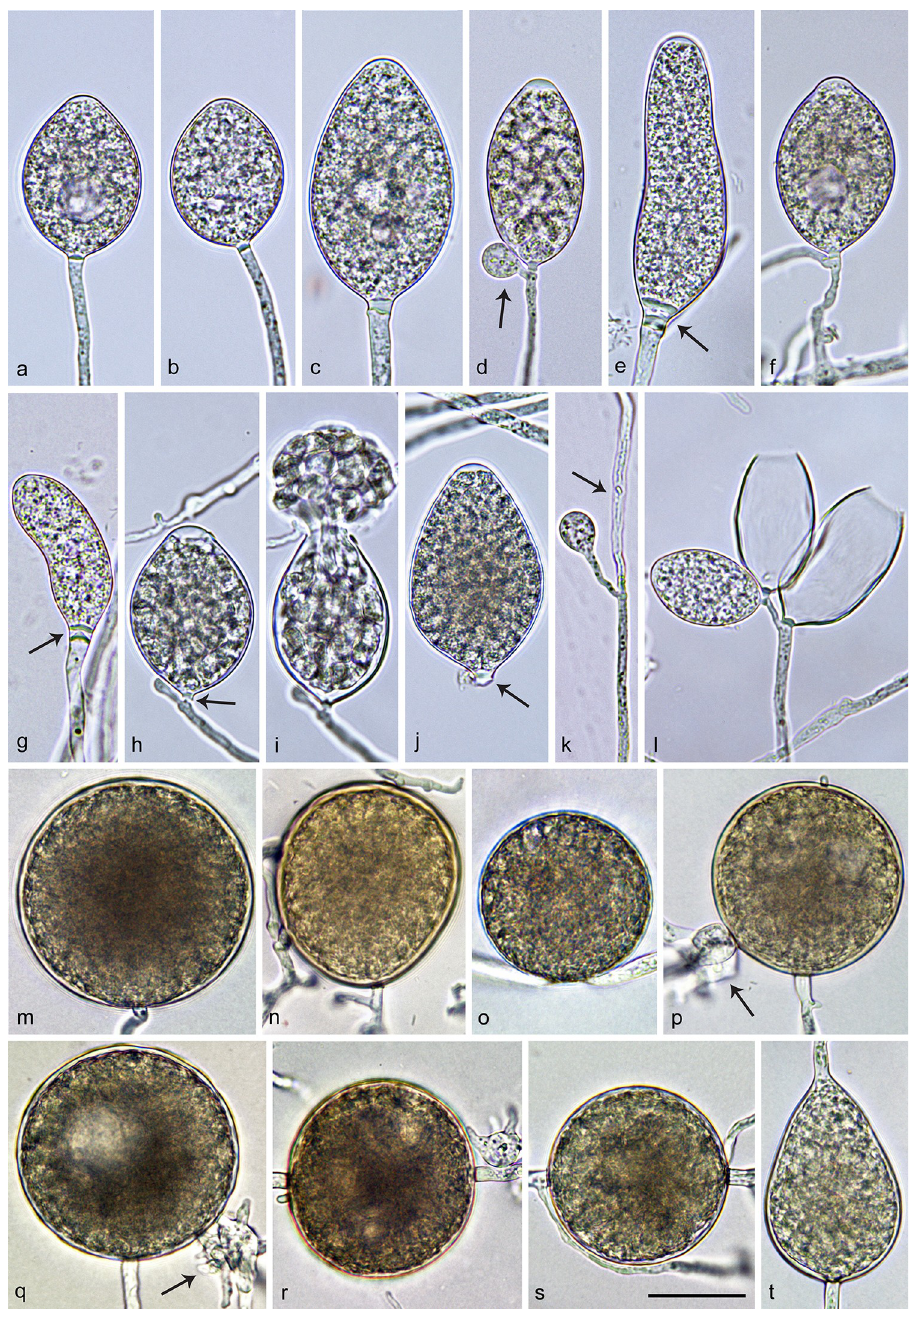
Fig 7. Morphological structures of Nothophytophthora lirii . a–l. structures formed on V8 agar flooded with non- sterile soil extract. a–j. mature sporangia with conspicuous basal plugs; a. nonpapillate, ovoid with vacuole; b. nonpapillate, ovoid, slighly laterally attached; c. nonpapillate, elongated-ovoid; d. ellipsoid, with swollen apex before zoospore release and with beginning external proliferation (arrow); e. nonpapillate, elongated-obpyriform with two basal plugs (arrow); f. nonpapillate, limoniform, on a short lateral hypha, with vacuole and external proliferation; g. nonpapillate, elongated-ellipsoid, curved, with two basal plugs (arrow); h. ovoid, with swollen apex before release of the fully differentiated zoospores, with beginning external proliferation; almost breaking-off at the basal plug (arrow); i. same ovoid sporangium as in g releasing zoospores; j. elongated-ovoid, caducous sporangium with short pedicel–like basal plug (arrow); k. secondary, lateral sporangium forming just below the empty upper section of the sporangiophore (arrow); l. dense sympodium with two empty sporangia after zoospore release and one immature limoniform sporangium; m–t. structures formed in solid V8 agar; m–s. globose or subglobose thick-walled chlamydospores;